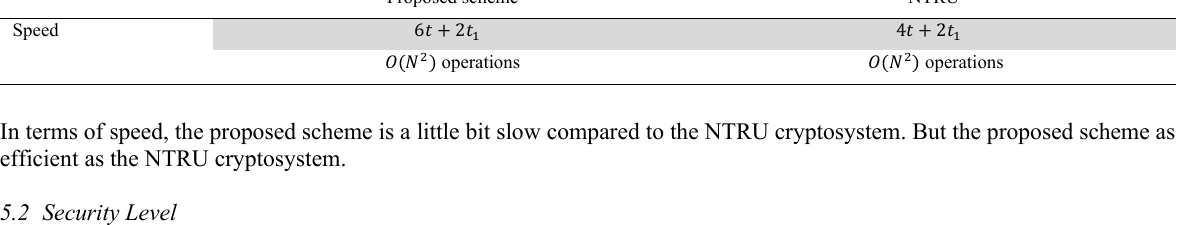
Speed of the Proposed Scheme and the NTRU Speed